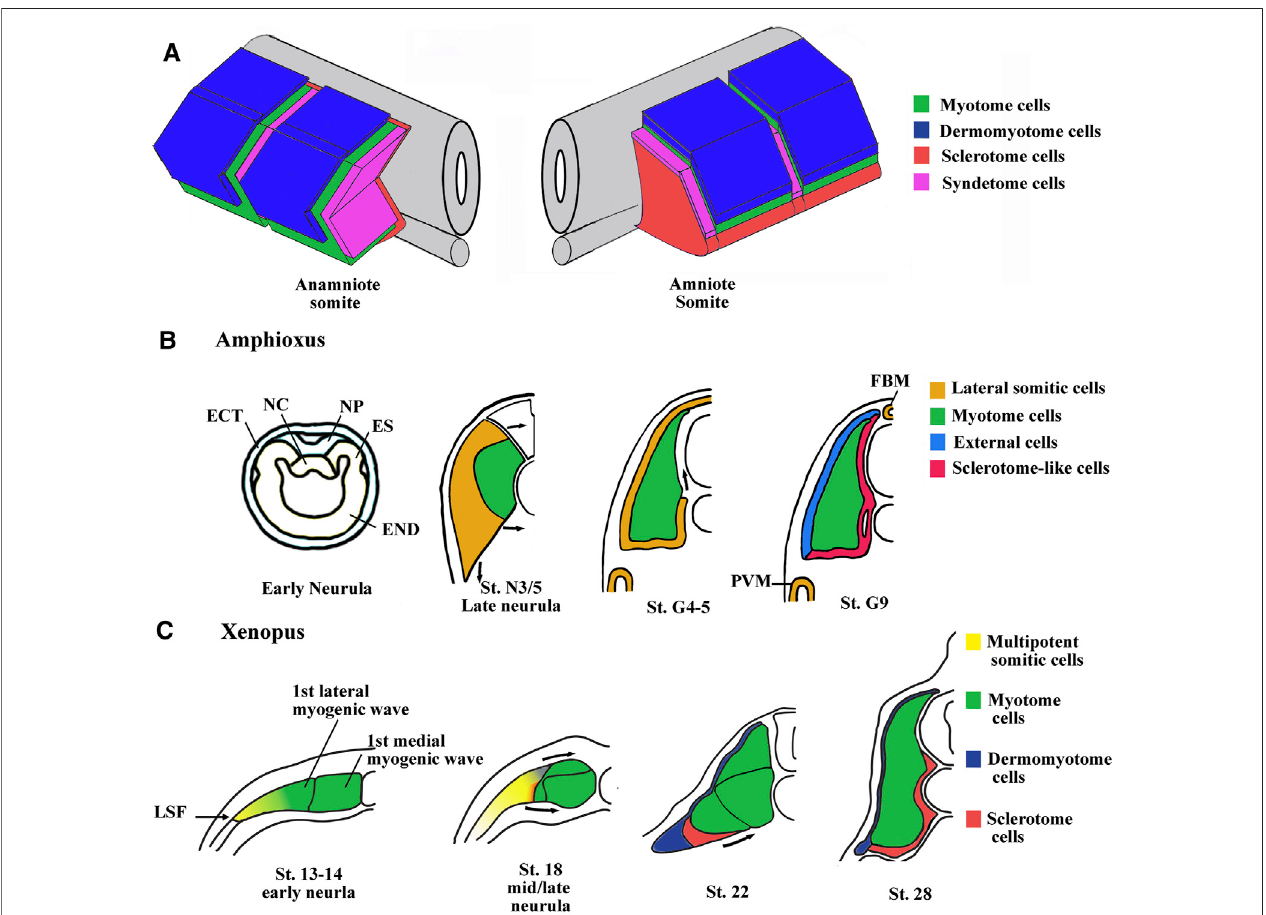
FIGURE 1 | Main characteristics of somite compartmentalization in vertebrates. (A) Comparison of somite organization between amniotes and anamniotes. Schematic view of somites slightly after the phylotypic stage. In anamniotes, the somite organization is adapted to the ondulatory swimming of the larvae and harbors a chevron shape with the myotome occupying the majority of the somite. The thin layer of dermomyotome cells is in dorso-lateral position and the sclerotome layer is ventro-medially stranded between the myotome and the midline structures (neural tube and notochord). The syndetome at the origin of the dorsal tendons arises from the sclerotome. The tenocytes project cytoplasmic extensions between muscle cells of adjacent somites. In amniotes, the spatial organization is the same, but the myotome compartment is reduced and the sclerotome is larger. (B) Somite compartmentalization in amphioxus. The anterior and intermediate somites are formed by enterocoely from the endoderm at the early neurula stage. The somites are subdivided into a medial myotome and a lateral domain at late neurula stage. The sclerotome-like cells seem to migrate from the lateral domain to position themselves medially between the myotome and the axial structures. The lateral domain also gives rise to the dorsal external cells, the medial fi n box mesothelium (FBM) and the latero-ventral perivisceral mesothelium (PVM). Modi fi ed from Mans fi eld et al. (2015) and Yong et al. (2021). ES, epithelial somite; NC, notochord; NP, neural plate; END, endoderm; ECT, ectoderm. (C) Somite compartmentalization in Xenopus . The somite is initially medio-laterally organized with the myotome in medial position and multipotent somitic cells (MSCs) in lateral one. The myotome forms fi rst and is initially made up of a medial- and a lateral-population of muscle cells. The MSCs appear at lateral somitic Frontier (LSF) at the beginning of neurulation and envelop next dorsally and ventrally the myotome to give rise to both dermomyotome and sclerotome.